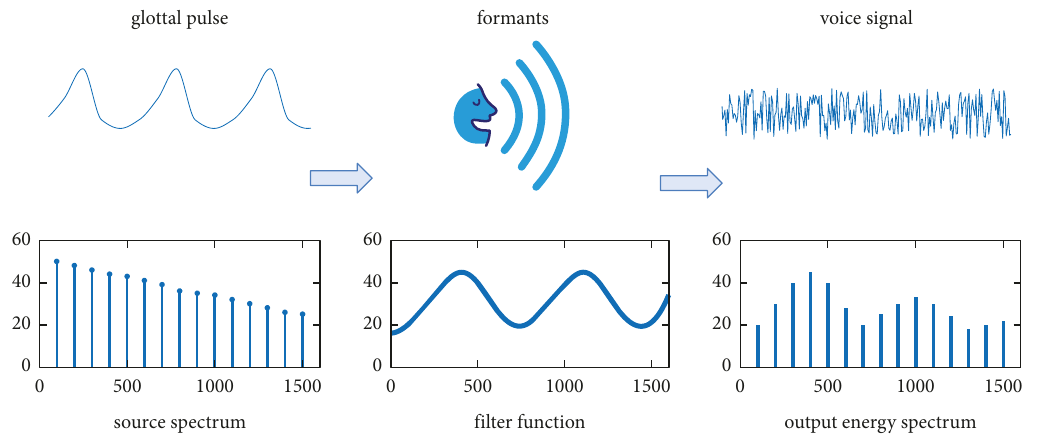
Figure 1: Correspondence between pronunciation process and spectrum.